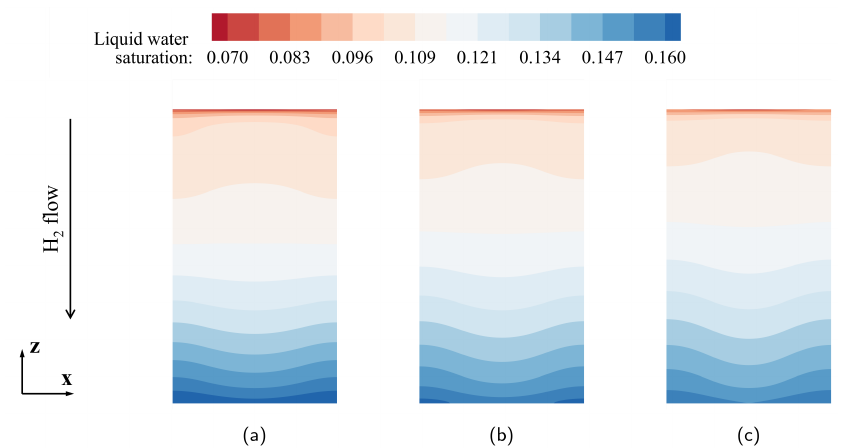
Figure 15. Impact of the LCWR on the liquid water saturation over the middle plane of the